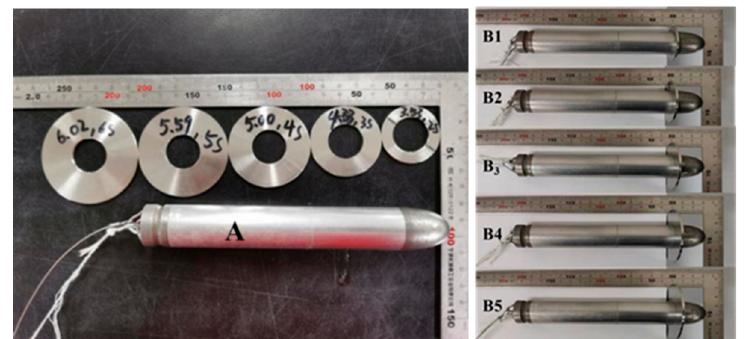
Figure 2. Model of torpedo anchors.